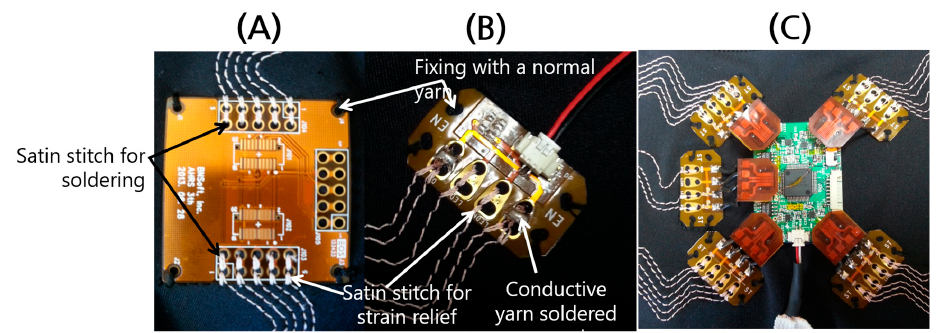
Figure 4. FPCBs for interconnection attached to clothes through a circuit patterning process using conductive yarn. ( A ) FPCB for sensor module. ( B ) FPCB for actuator. ( C ) Stretchable circuits.